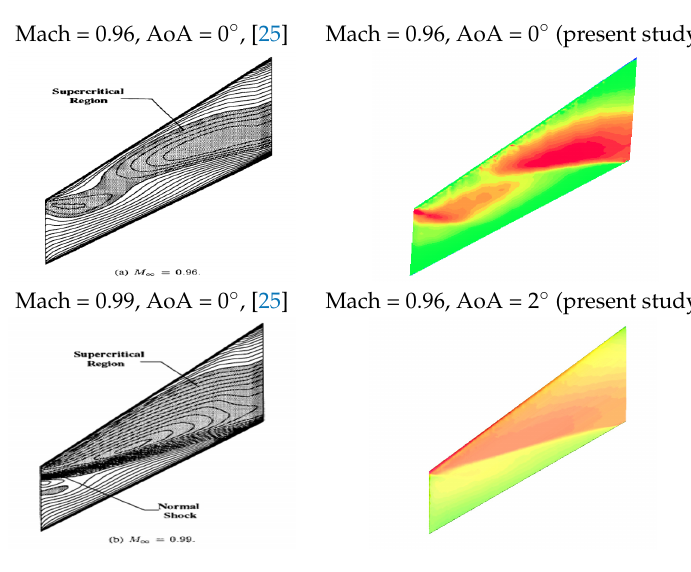
Table A5. Mach number contours on the upper surface for M = 0.96 and M = 0.99 [25] (top and bottom left), the present study (top right) for M = 0.96, AoA = 0 ◦ , and the present study (bottom right) for M = 0.96, AoA = 2 ◦ .